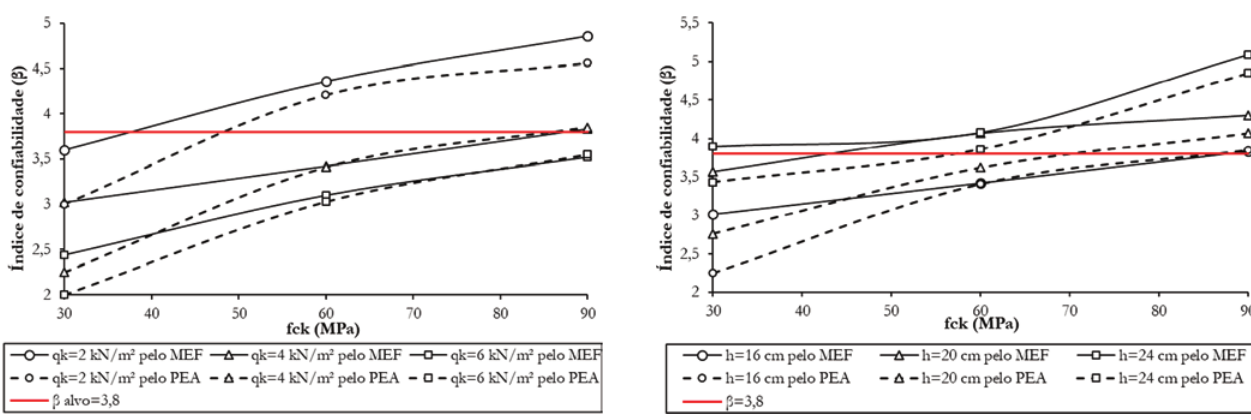
Análise do índice de confiabilidade para as lajes com carregamento acidental de 4